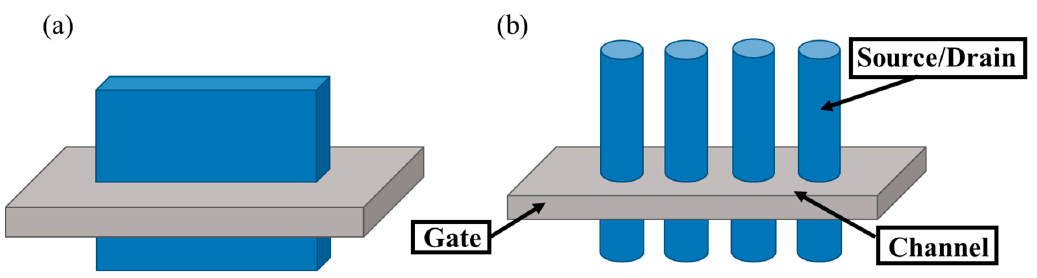
Figure 1. Schematics of vertical gate-all-around field effect transistors (GAAFETs): ( a ) Vertical nanosheet GAAFET and ( b ) vertical nanowire GAAFET. Vertical nanowires—Lg and spacer dimension are decoupled from the gate pitch. Density is determined by distance between the wires. Many